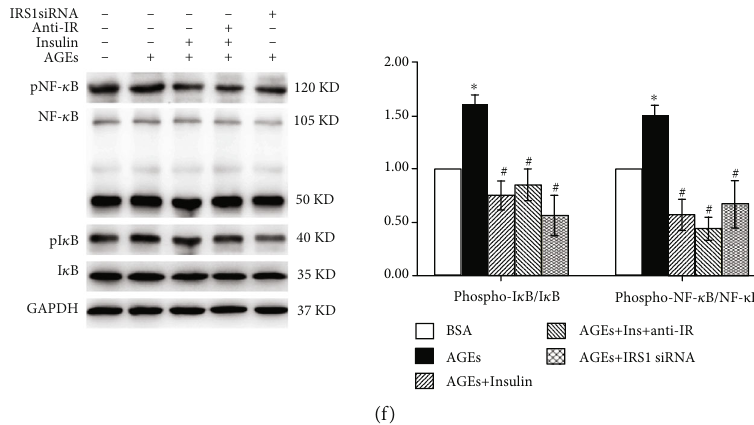
Figure 6: The role of IR and IRS1 in AGEs-BSA-stimulated BMDCs immune maturation. (a) Flow cytometric analysis was performed for cell surface CD83, CD86, and MHC-II expression examinations. IRS1 siRNA attenuated AGEs-BSA-induced CD83 and CD86 upregulation; (b) the concentrations of TNF- α , IFN- γ , IL-6, IL-1b, and CCL2 in the supernatants of the culture were measured by ELISA; (c, d) the expressions of cytokines and chemokines mRNA in BMDCs were analyzed by real-time quantitative RT-PCR. IRS1 siRNA attenuated AGEs-BSA-induced the expressions of cytokines and chemokines and upregulated the expression of IL-10; (e) the expressions of NF- κ B and I κ B were determined by western blot with the samples treated with IRS1 speci fi c siRNA or scramble siRNA. The phosphorylation of NF- κ B and I κ B was downregulated after IRS1 silencing; (f) the expressions of NF- κ B and I κ B were determined by western blot in the presence of IR neutralizing antibody or insulin or IRS1 siRNA. The results showed that the IR-neutralizing antibody had no impact on the suppressing e ff ect of insulin. Insulin treatment and IRS1 silencing showed no signi fi cant impact on the suppression of phosphorylation of NF- κ B and I κ B. Data are expressed as mean ± SED ; n = 5 ; ∗ p < 0 : 05 vs. control group; # p < 0 : 05 vs. AGEs-BSA group; Δ p < 0 : 05 vs. AGEs + Insulingroup . AGEs-BSA: advanced glycosylation end-bovine serum albumin; BMDCs: bone marrow-derived dendritic cells; IRS1: insulin receptor subunit-1; IR: insulin receptor; TNF- α : tumor necrosis factor- α ; IFN- γ : interferon- γ ; MHC-II: major histocompatibility complex-II; NF- κ B: nuclear factor- κ B.